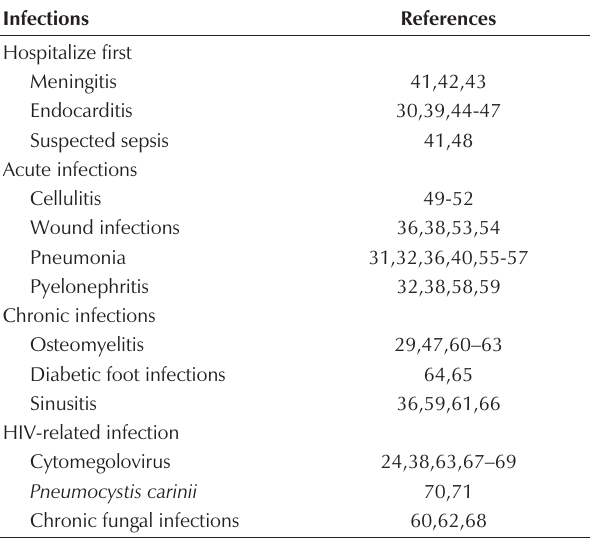
Infections amenable to outpatient parenteral antibiotic